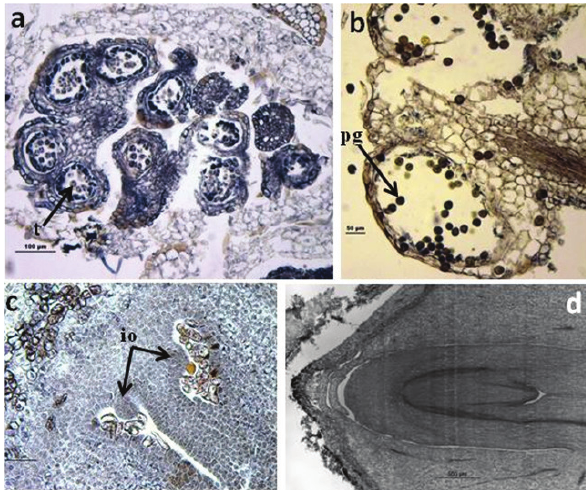
FiGure 6. Histological sections on 13 May: a) male flower with tetrads (t), bar 100µm; b) pollen grains (pg) within an anther, bar 50µm; c) female flower with immature ovules (io), bar 50µm on 9 October; d) embryo completely formed, bar 500µm.